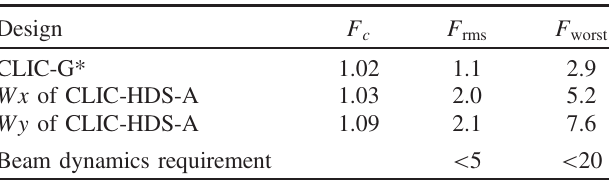
TABLE II. Transverse beam jitter amplification factors in wakefield suppression of CLIC-HDS-A.